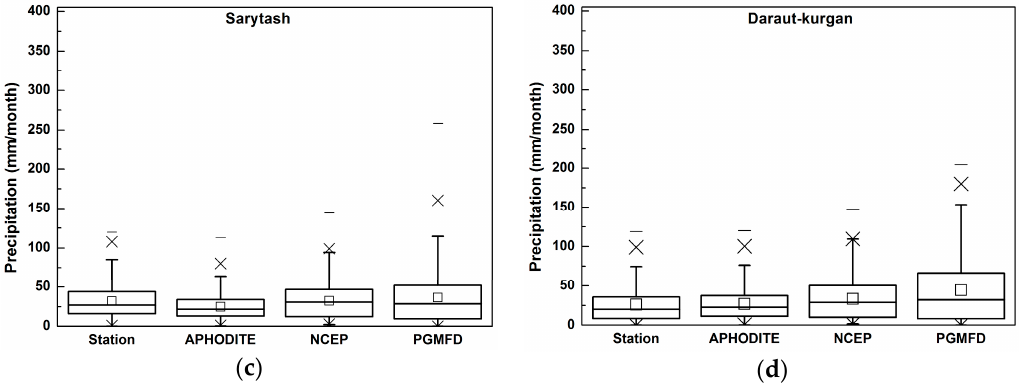
Figure 4. Box plots of precipitation based on WSD and gridded data sets at four stations. ( a ) box plot of precipitation at Lyairun station; ( b ) box plot of precipitation at Fedchenko Glacier station; ( c ) box plot of precipitation at Sarytash station; ( d ) box plot of precipitation at Daraut ‐ Kurgan station.